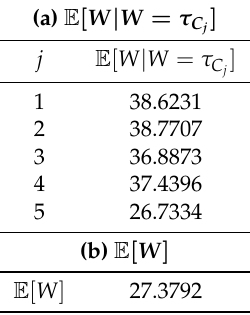
] , j = 1, . . . ,5 and unconditional mean E [ W ] for Example j